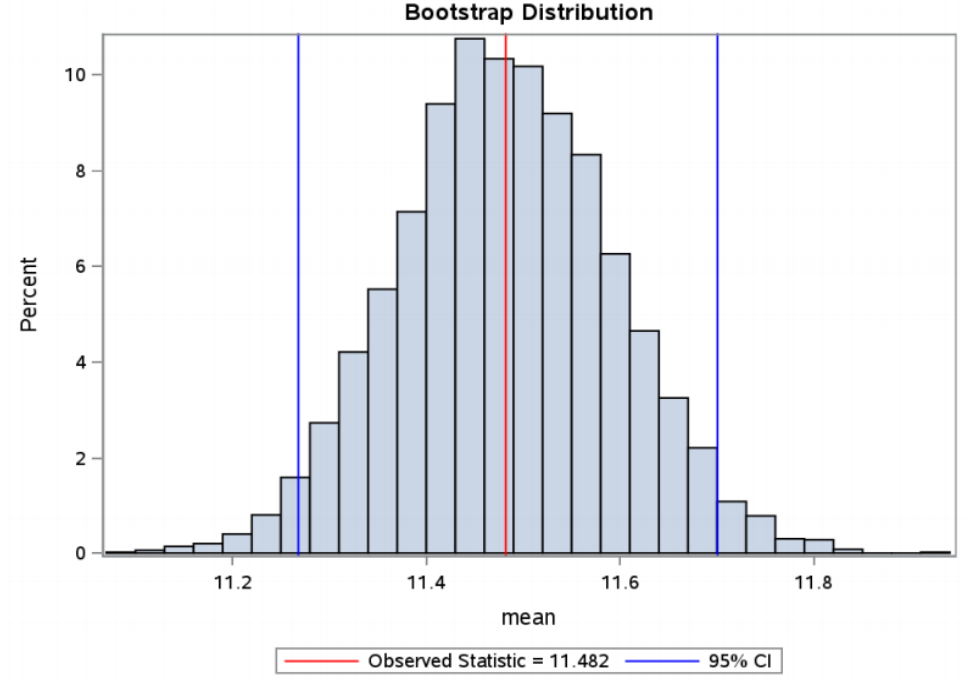
Figure 4. cc2: bootstrap distribution—distribution according to the duration of the 2nd cell cycle in a group of embryos with FHB (in hours). Bootstrap distribution cc2: 95% Lower CI 11.2681, 95% Upper CI 11.7004, FHB = fetal heartbeat.